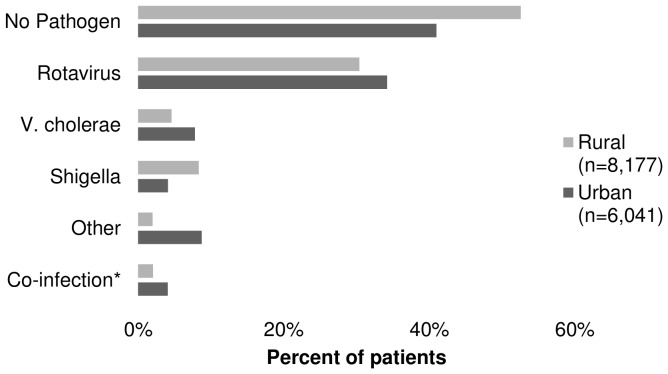
Frequency of detected enteric pathogens among children under five in ICDDR,B hospitals, Bangladesh, 2000–2008.* Co-infection is defined as a positive assay for two or more non-cholera pathogens. Patients with V. cholerae co-infection were excluded from analyses.